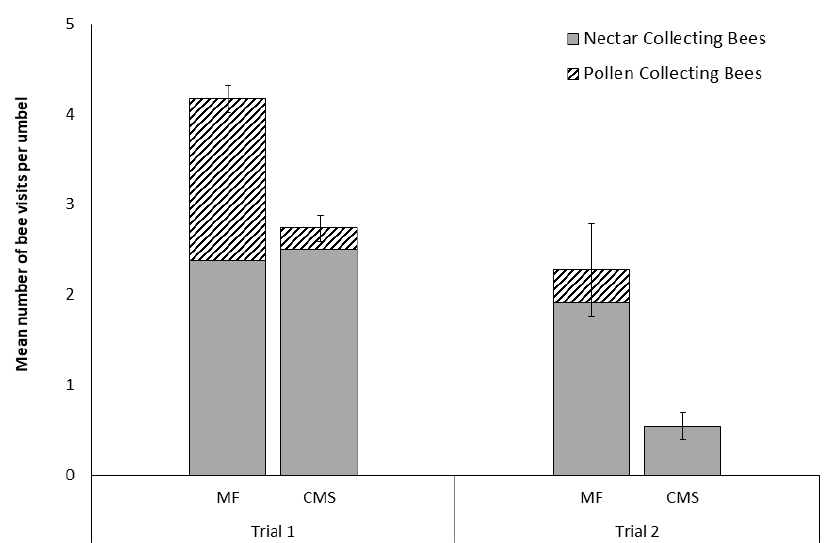
Figure 1. Number of Apis mellifera (mean ± SE) visiting pairs of male-fertile (MF) and cytoplasmically male-sterile (CMS) carrot umbels in trials. (Trial 1; n = 92 pairs, observations for five minutes per umbel. and Trial 2; n = 13 pairs, observations for 20 minutes per umbel) subdivided into proportions of nectar and pollen collecting bees observed.